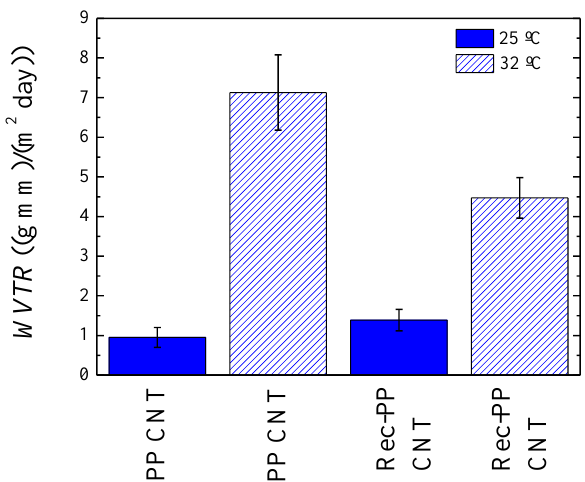
Figure 9. Water vapor transmission rate for PP/CNT and rec-PP/CNT at 25 and 32 °C.